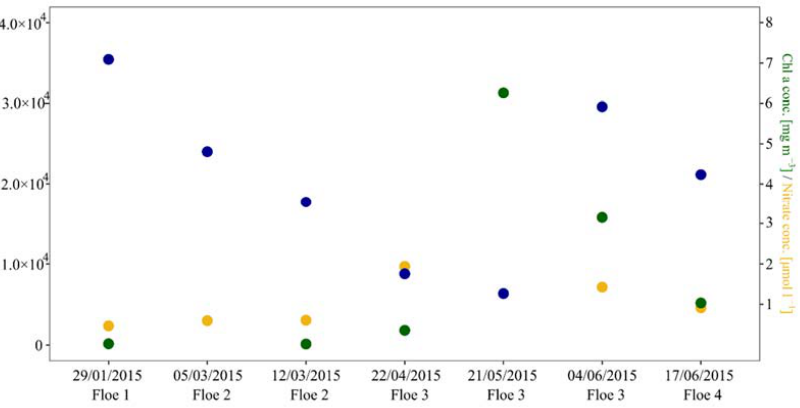
Figure 2. Bacterial and archaeal cell abundance (blue), chlorophyll a concentration (green), and nitrate concentration (yellow) during the five months of the N-ICE2015 observation. Gaps in the graph are due to missing values on these days.